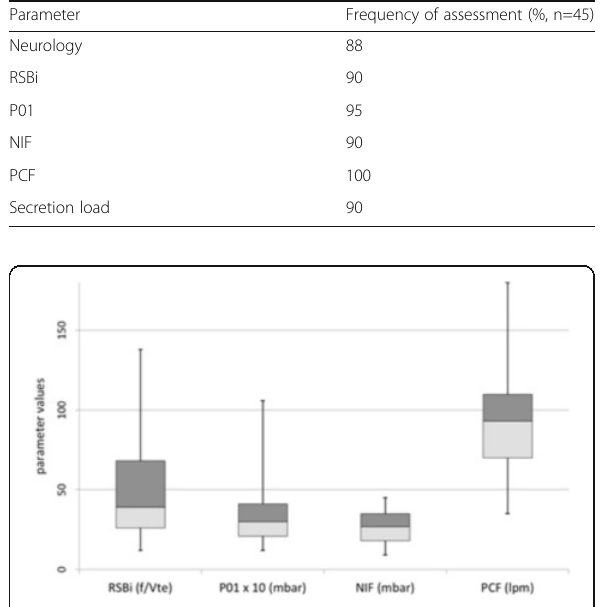
Fig. 99 (abstract A228). Ranges of parameters assessed